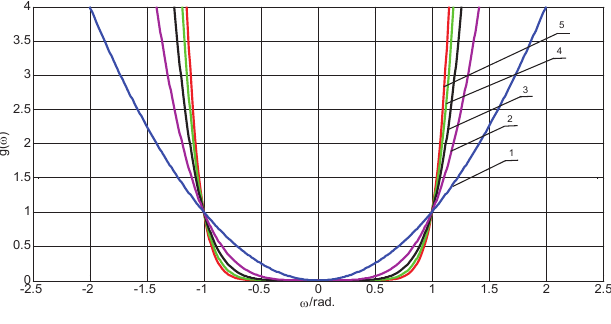
Figure 1. Waveforms of g ( ω ) for various n (i.e., from 1 to